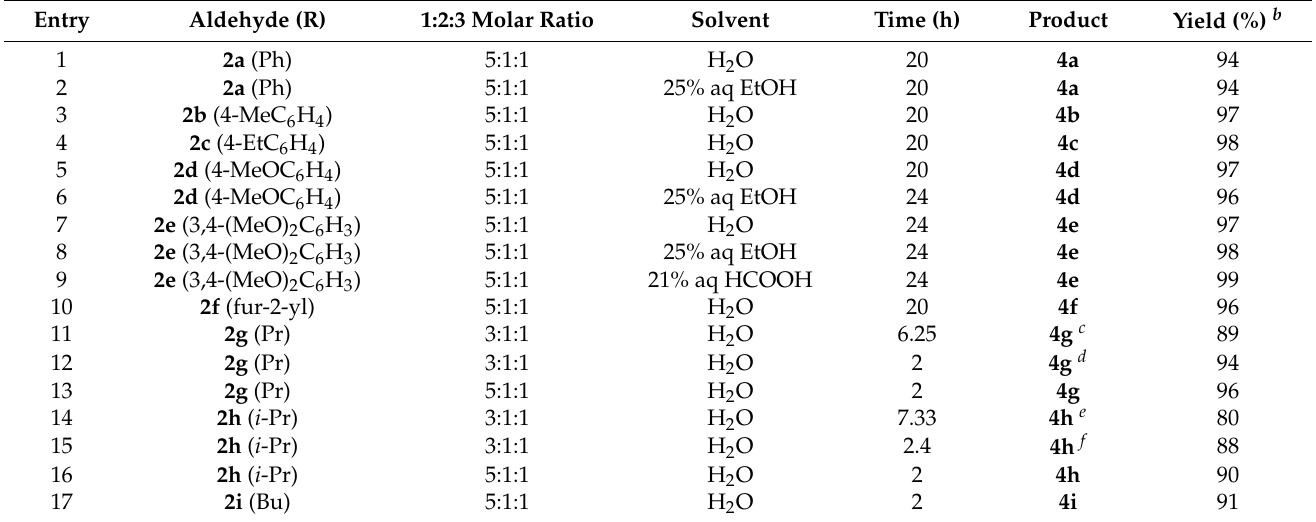
Table 1. Synthesis of N -(tosylmethyl)-substituted ureas 4a-i a .